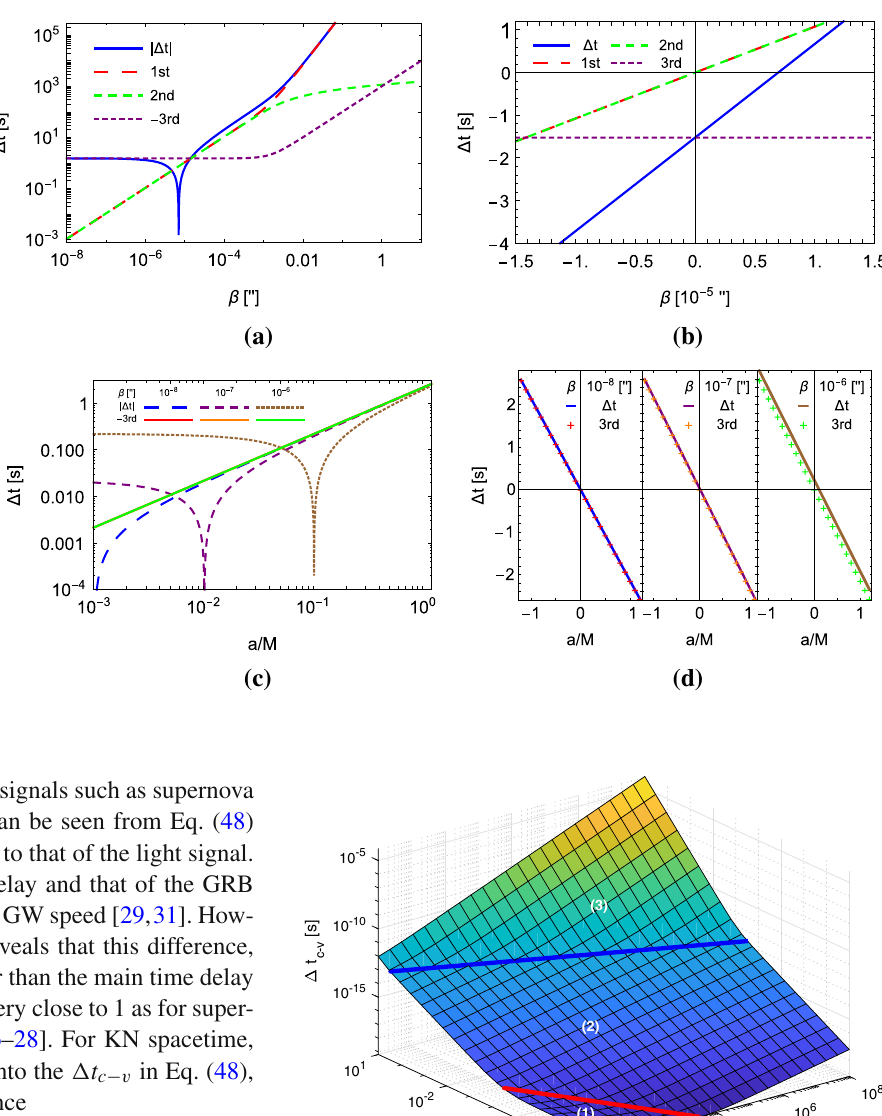
Fig. 4 The time delay difference (56) for the KN spacetime as a func- tion of β and r s = r d = D for a GW with speed v = ( 1 − 3 × 10 − 15 ) c . The red and blue curves are plotted using β 2 r s , d = a / r s , d and β 2 r = M s , d